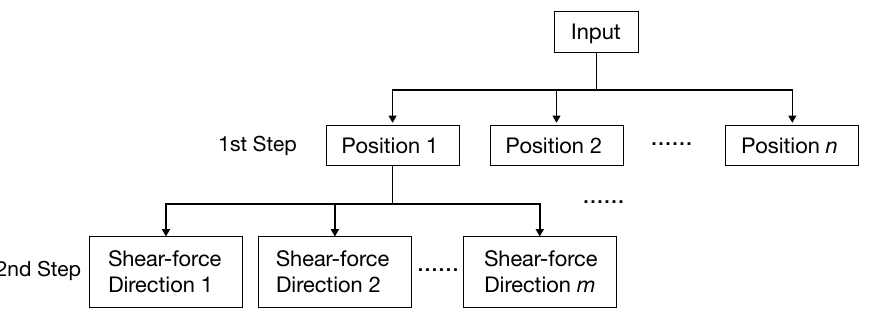
Figure 3. Overview of two-step